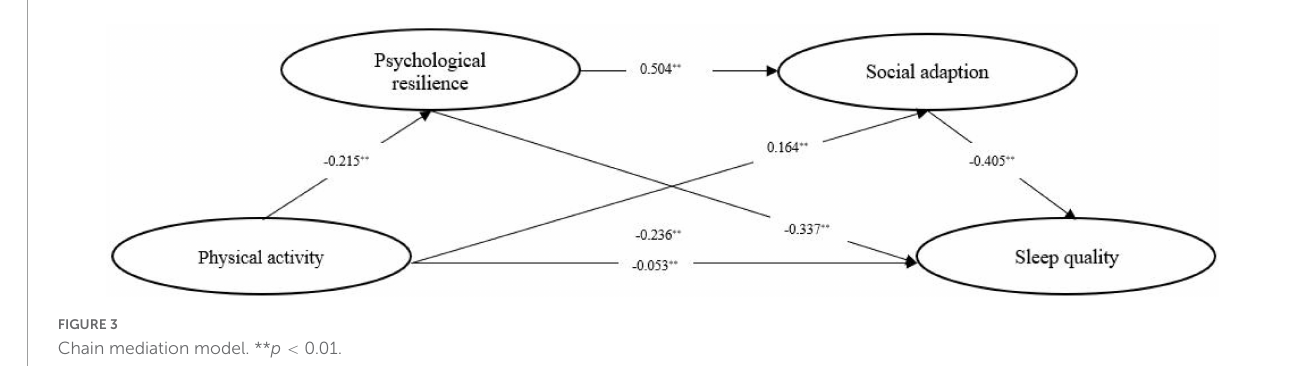
FIGURE3 Chain mediation model. ** p <